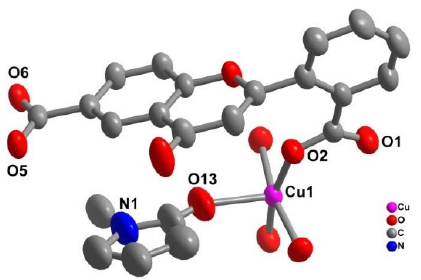
Figure 1. The crystal structure of LDU-1, H atoms and lattice solvents omitted for clarity.